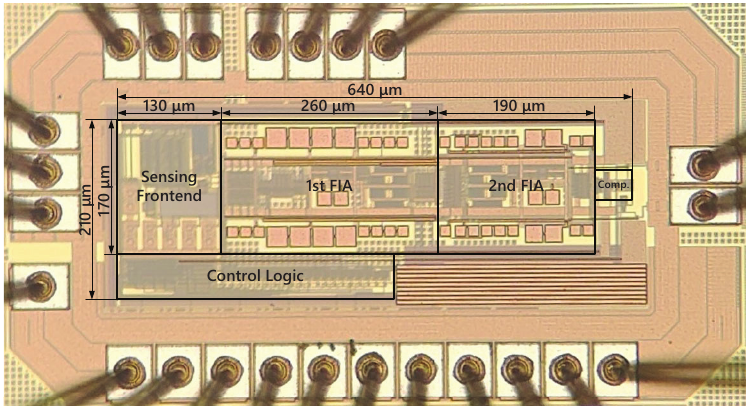
Figure 11. Photomicrograph of the temperature sensor.